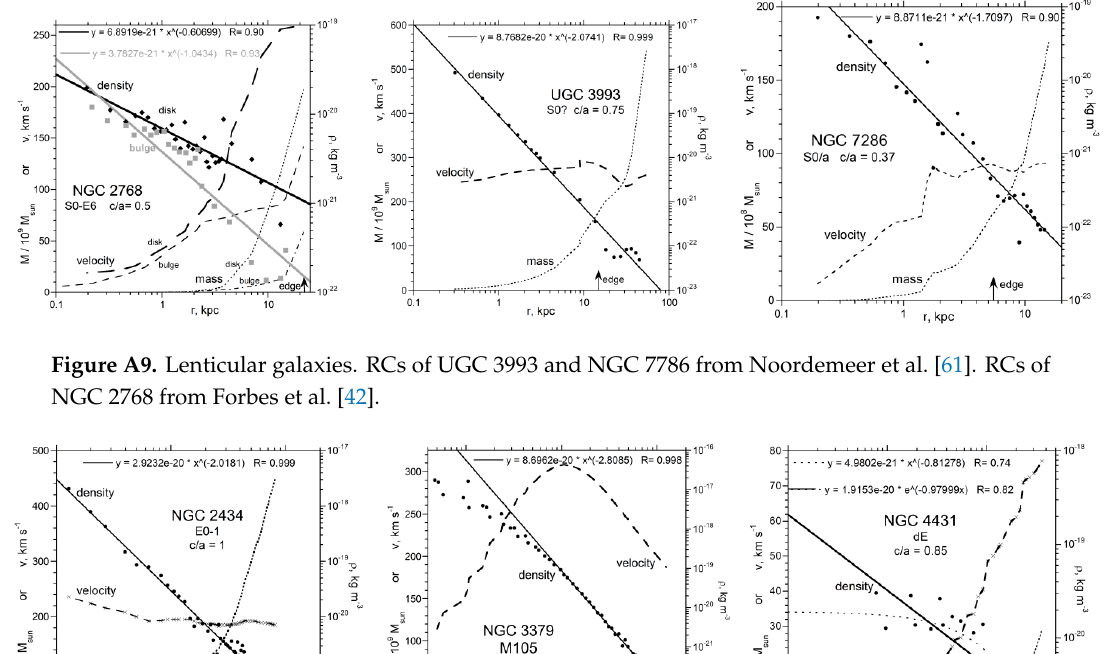
Figure A8. Dwarf spheroidal galaxies. RCs presented by Salucci et al. [75] were digitized. Original